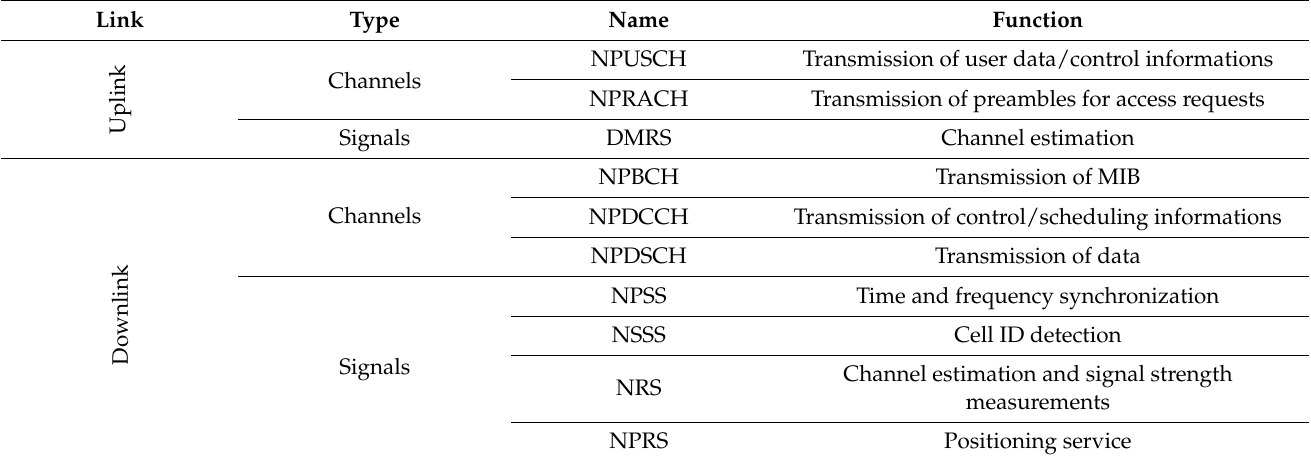
Table 3. NB-IoT channels and signals [13,15,18,31]. Adapted from ref